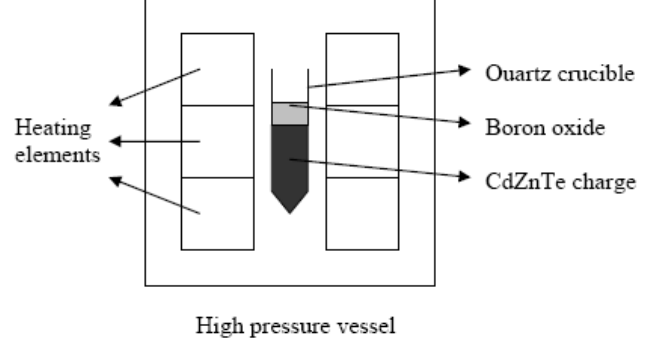
Figure 10. Growth set up of the boron oxide encapsulated vertical Bridgman technique.